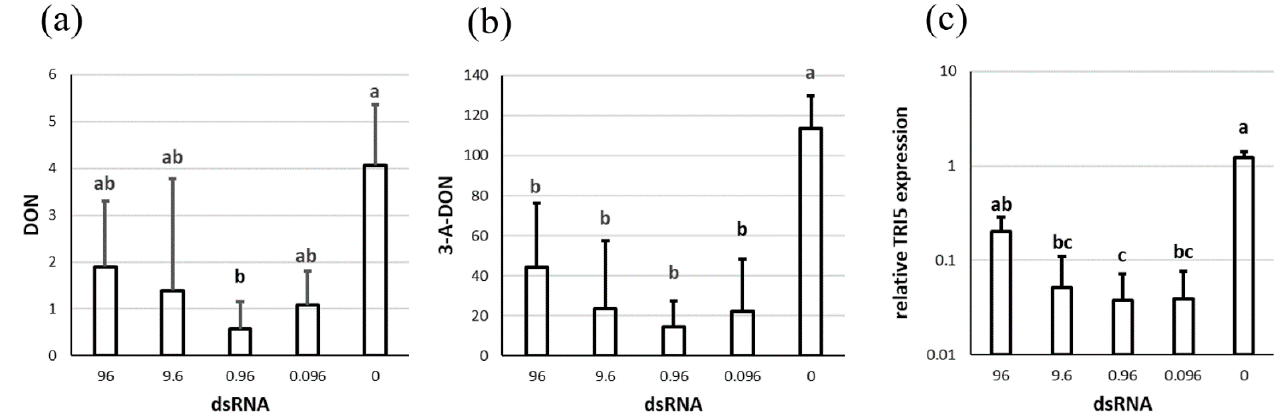
Figure 1. Trichotecene accumulation and TRI5 expression after silencing with dsTRI5RNA. ( a ) DON concentration and ( b ) 3-A-DON concentration in µg per g DW. ( c ) TRI5 expression relative to control sample and EF1A as a reference gene. The x-axis shows the amount of dsRNA (in µg) that was added to the cultures. The figure shows the means and standard deviation of three replicates. Letters above the columns indicate statistical significance; p -value ≤ 0.05.